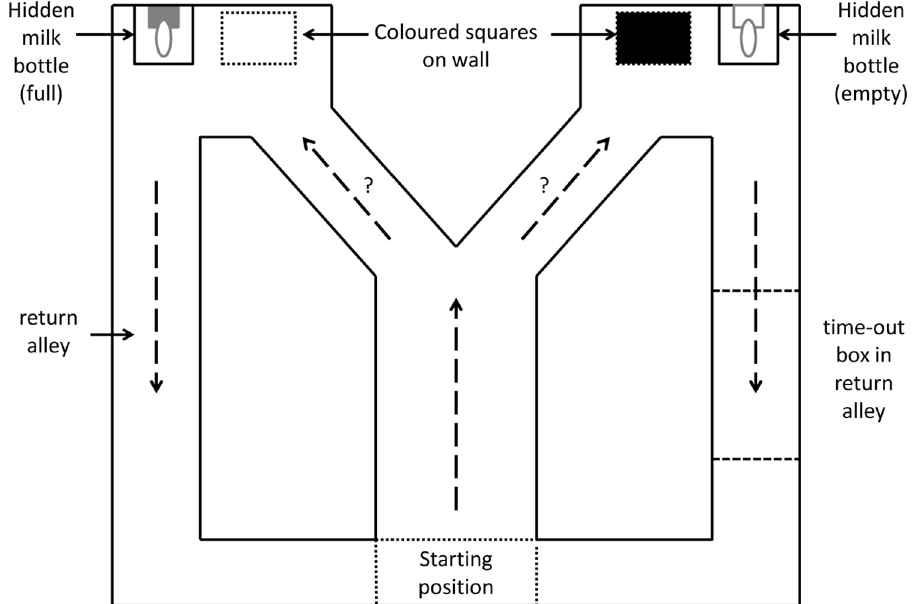
Figure 1. Experimental pen with Y-maze. In this example, the left arm contained a white square associated with a positive event (full milk bottle) and the right arm contained a black square associated with a negative event (empty milk bottle, followed by 20 sec in the time out box). Milk bottles were hidden by a bottle cover. Solid lines represent plywood partitions, and dashed arrows represent movement of the calf through the Y-maze. The starting position was indicated by painted lines on the pen floor. The experimental pen measured 3.0 6 4.6 m.